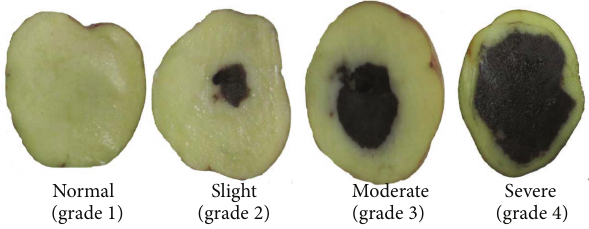
Figure 2: Example images of potatoes with different blackheart